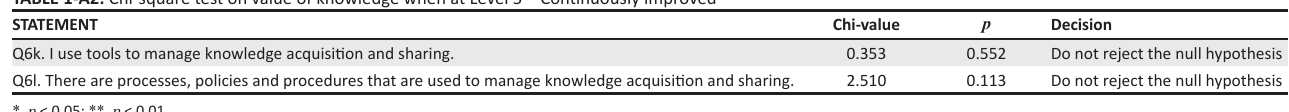
TABLE 1-A2: Chi-square test on value of knowledge when at Level 5 – Continuously improved